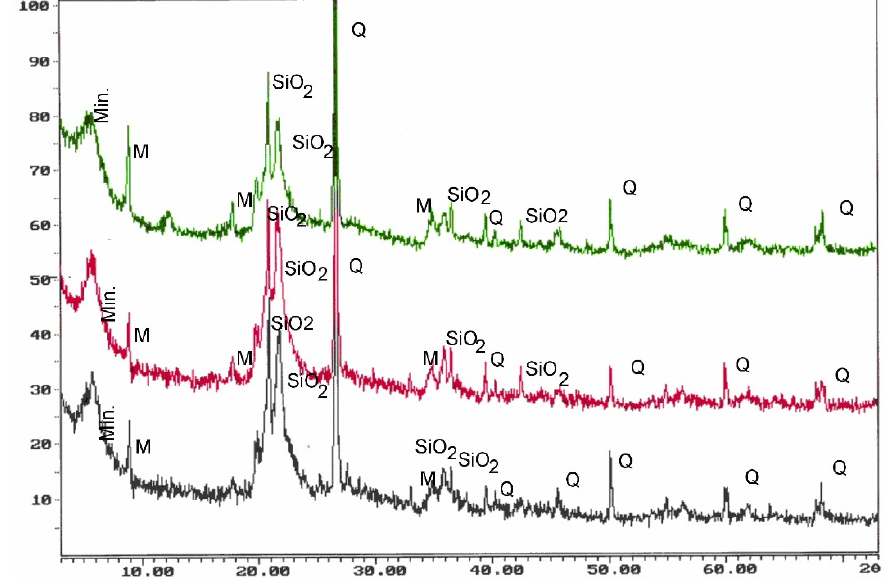
Figure 5. Example diffractometric curves. Explanation of symbols: SiO 2 –silica phases in the form of opal (CT varieties relative to C), Q–quartz, M–mica, Min.–clayey minerals.